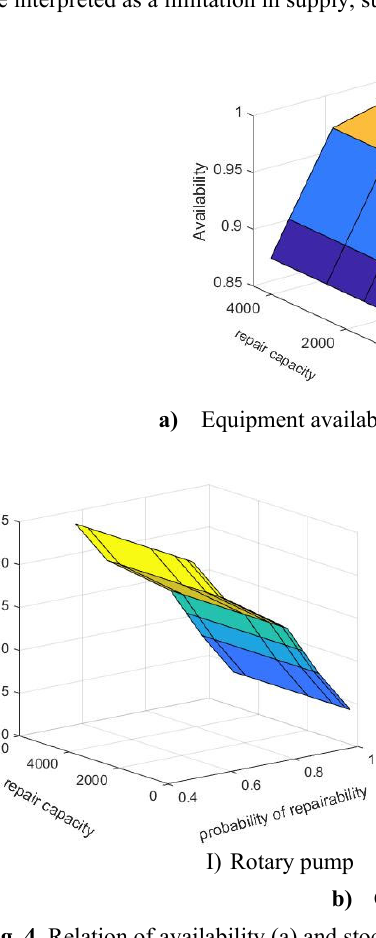
Fig. 4. Relation of availability (a) and stock level (b) with repair capacity and probability of repairability